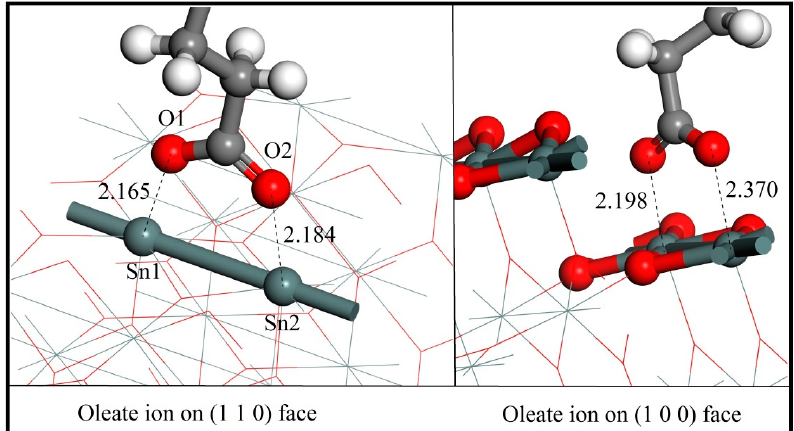
Figure 8. The bonding details of an oleate anion on cassiterite (110) and (100) surfaces (colour codes: Gray—C, White—H, Red—O, Dark Gray—Sn). Table 6. Comparison of adsorption energies of different adsorbates on cassiterite (110) or (100) surfaces. Adsorbate